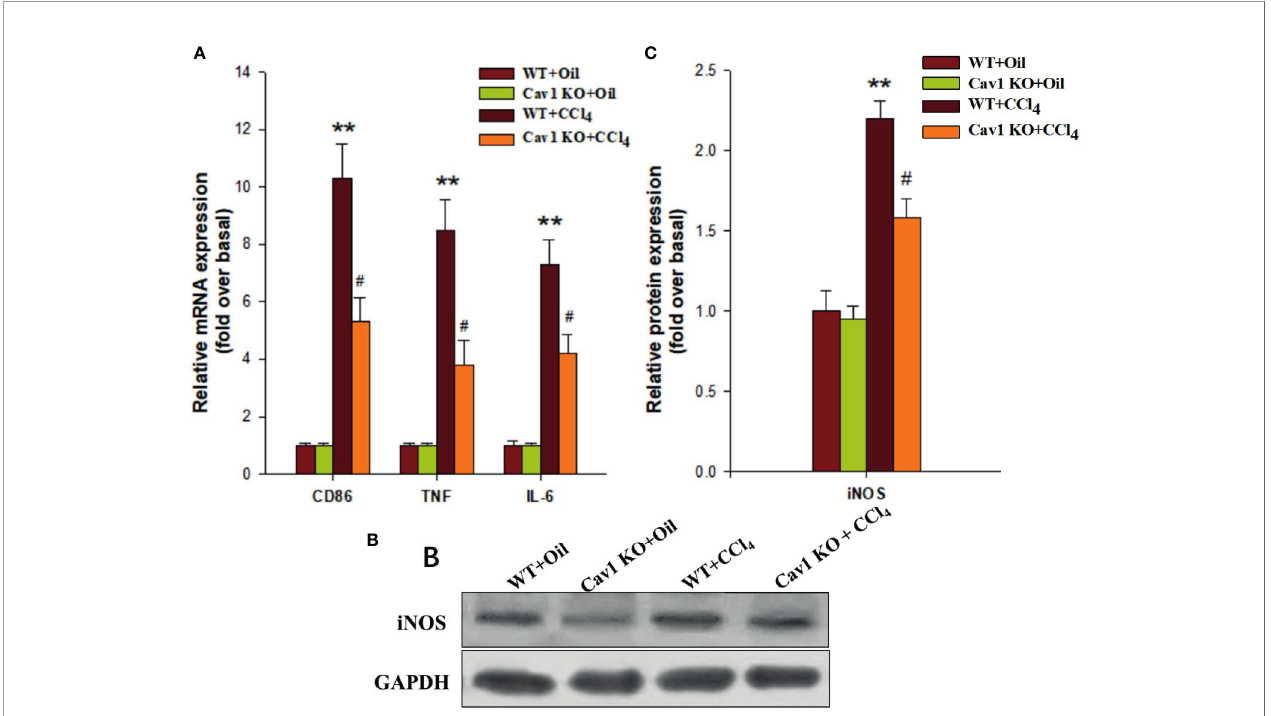
FIGURE 4 | Cav1 de fi ciency reduced polarization of macrophages to the M1 phenotype in injured liver. The expression of M1 markers was measured by RT-qPCR and Western blot. (A) At two weeks after CCl 4 administration, the mRNA expressions of M1 markers (i.e. CD86, TNF, and IL-6) were detected. (B) The expression of inducible nitric oxide synthase (iNOS) was measured by Western blot. (C) Quantitative analysis of iNOS expression in the injured liver. M1 markers were signi fi cantly downregulated in the liver of Cav1 KO mice compared to the WT group at 2 weeks after CCl 4 treatment. Data are shown as mean ± SD, ** p < 0.01 compared with the WT+oil group, # p < 0.05 compared with the WT+CCl 4 group. n=6 per